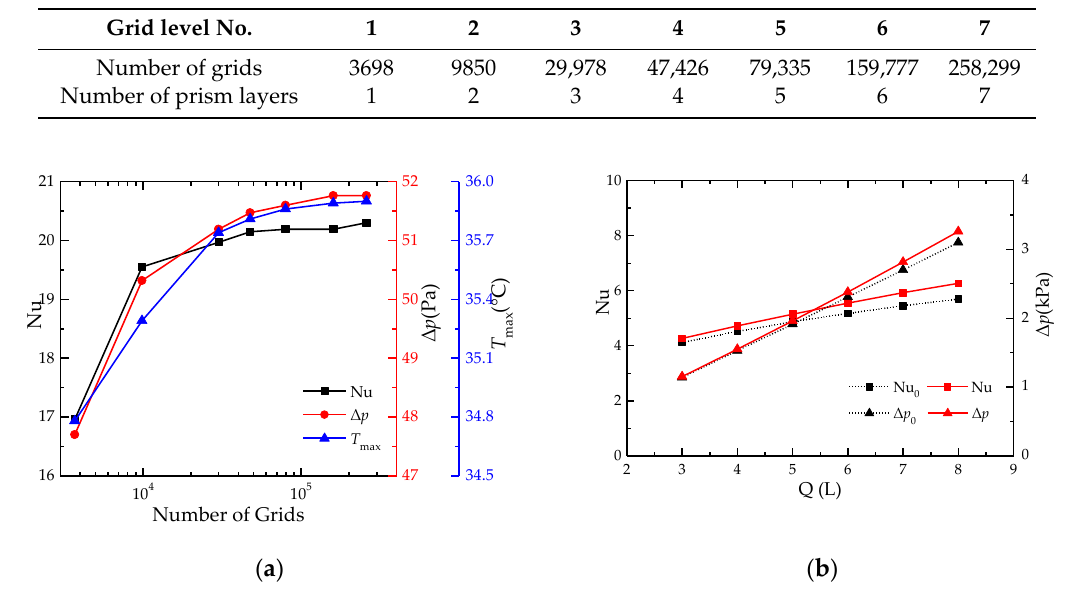
Figure 9. Grid independence. ( a ) Nusselt number, pressure loss, and maximum temperature calculated by different grid systems; ( b ) comparison of the Nusselt number and pressure loss of the theoretical and numerical results.